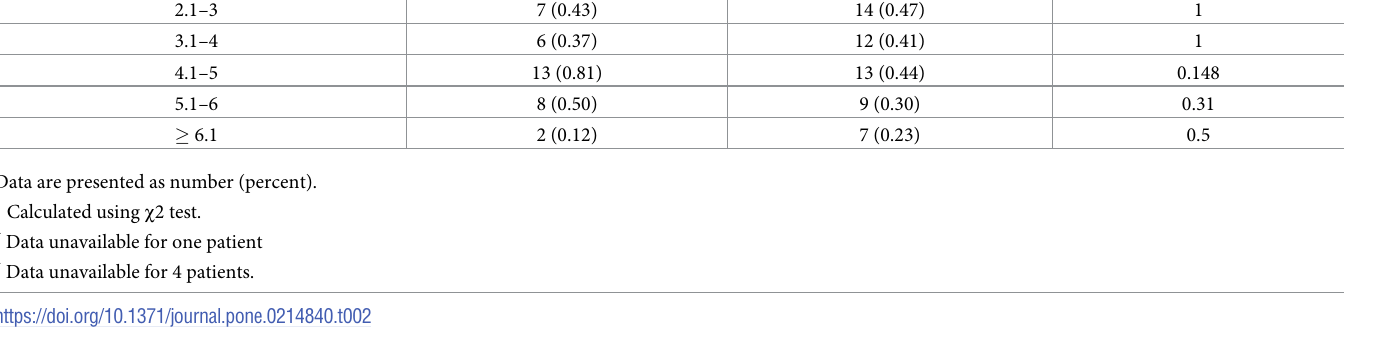
Table 2. Postpartum hemoglobin decrement among women with PPH according to ABO blood type. Hemoglobin Decrement